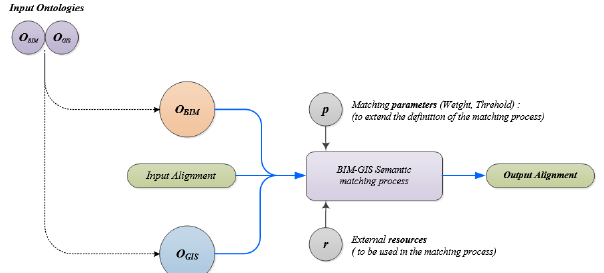
Figure 3. Semantic Alignment workflow of BIM-GIS integrated ontologies (A. Hadi. Hor, Jadidi, A., & Sohn, G.,